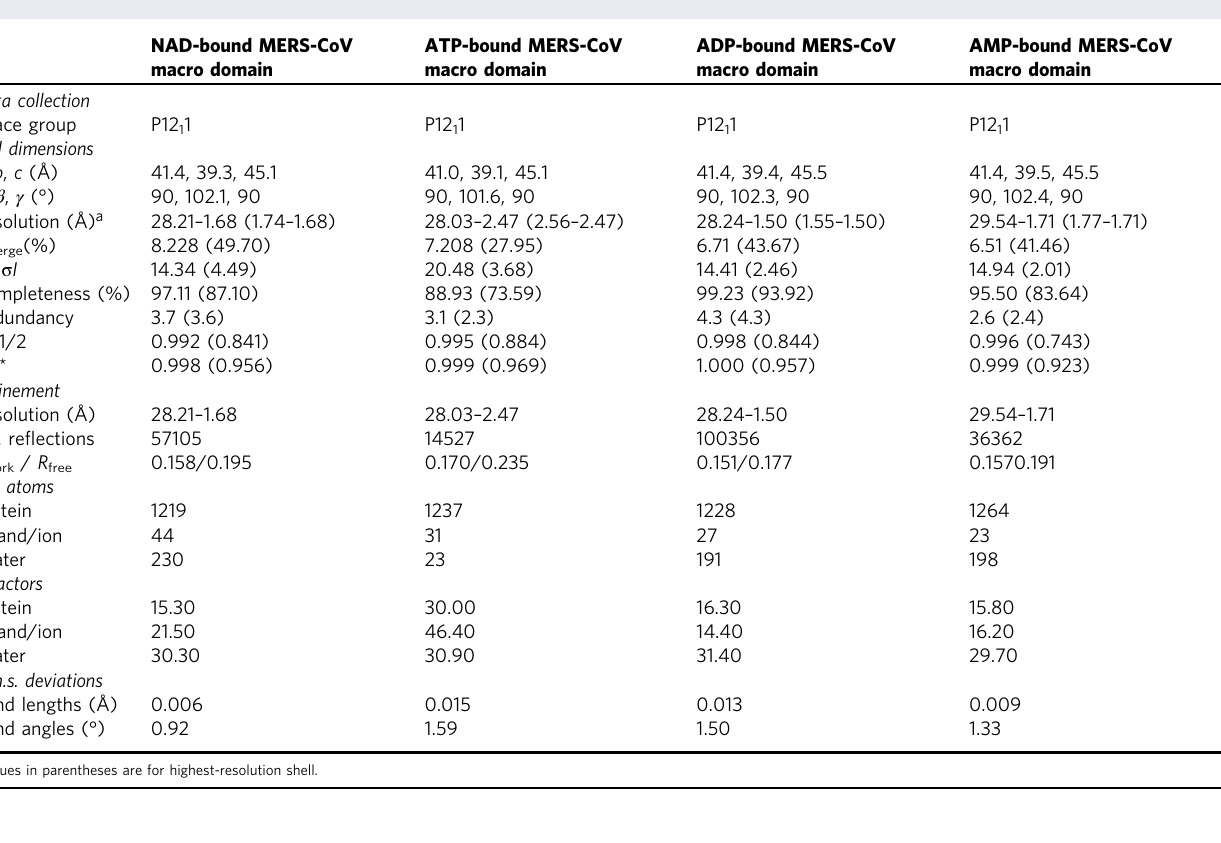
Table 2 Data collection and re fi nement statistics.